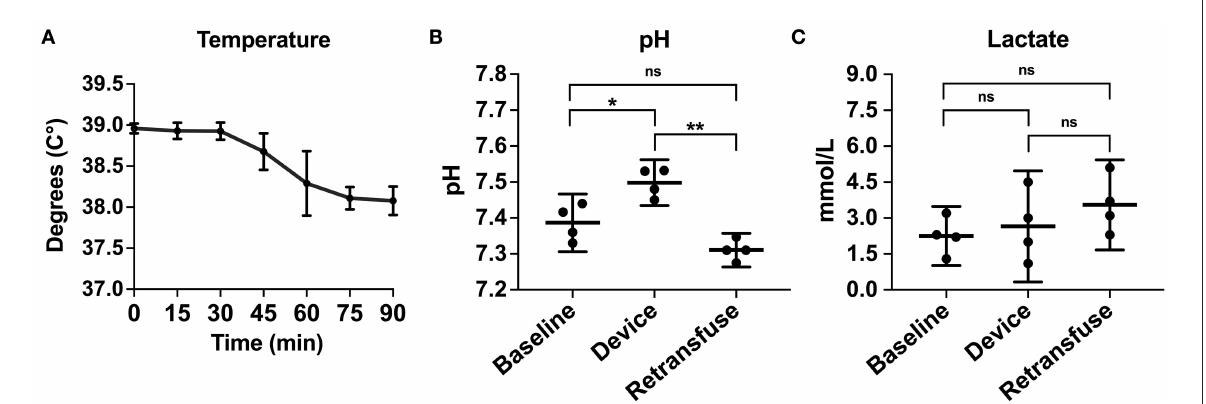
FIGURE6 The metabolic laboratory tests were performed over time or between samples from the animal at baseline, within the device, and the animal at retransfusion: (A) Temperature of the animals across time. (B) pH at baseline, device, and retransfusion with significant differences between baseline vs. device and device vs. retransfusion but no difference between baseline vs retransfusion, and (C) lactate at baseline, device, and retransfusion without any significant differences. The central lines represent the means and the error bars represent the standard deviation. p < 0.05 is represented by *, a p < 0.001 is represented by **, and nonsignificant p values are presented by ns.